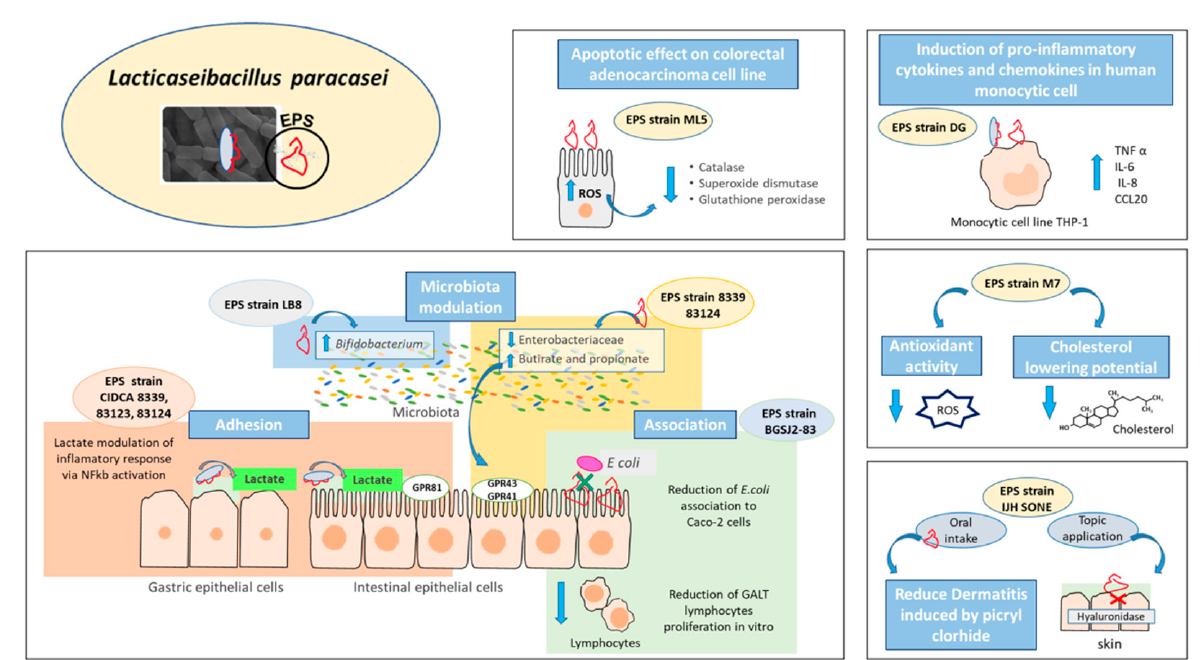
Figure 2. Beneficial effects and mechanisms ascribed to EPS isolated from L. paracasei strains. At the gastrointestinal level, EPS produced by the BGSJ2-83 strain reduced the association of E. coli to Caco-2 cells and reduced GALT lymphocyte proliferation in vitro. EPS from the LB8 strain modulated the microbiota composition due to a bifidogenic effect; meanwhile, EPS from CIDCA 8339 and CIDCA 83124 strains reduced Enterobacteriaceae. In addition, EPS isolated from CIDCA 8339 and 83124 produced a change in the concentration of short chain fatty acids by increasing the butyrate and propionate levels. EPS is involved in the bacteria association to epithelial cells where the in situ production of lactate modulated the inflammatory response via NFkb activation. Additionally, EPS from MLS strain exerted an apoptotic effect on the human colorectal adenocarcinoma cell line HT-29. The oral intake of EPS produced by IJH-SONE reduced dermatitis induced by picryl-clorhide, and the topical application of EPS reduced the inflammation in mice. EPS produced by the DG strain induced pro-inflammatory cytokines and chemokines in the human monocytic cell line THP-1. EPS isolated from M7 strain presented anti-inflammatory activity and reduced cholesterol levels. ROS: reactive oxygen species.